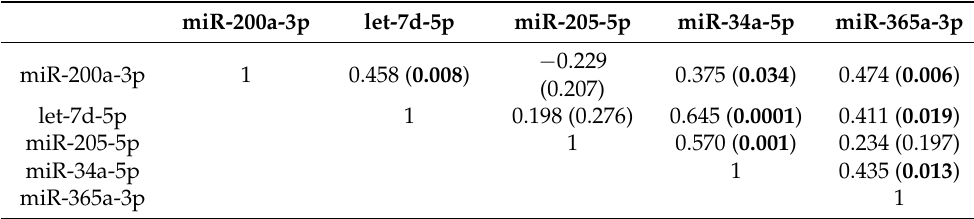
Table 2. Correlation among the miRNAs dysregulated in ccRCC patients before surgery (t 0 ) compared to controls. Spearman correlation coefficients between two miRNAs are detailed. Significant p -values are depicted in bold.